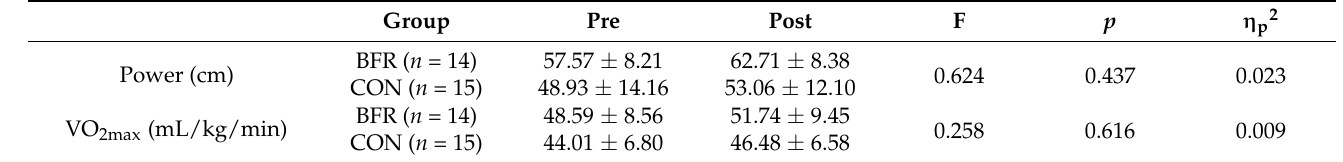
Table 3. Change in physical fitness after low-intensity aerobic training combined with BFR. Group Pre Post